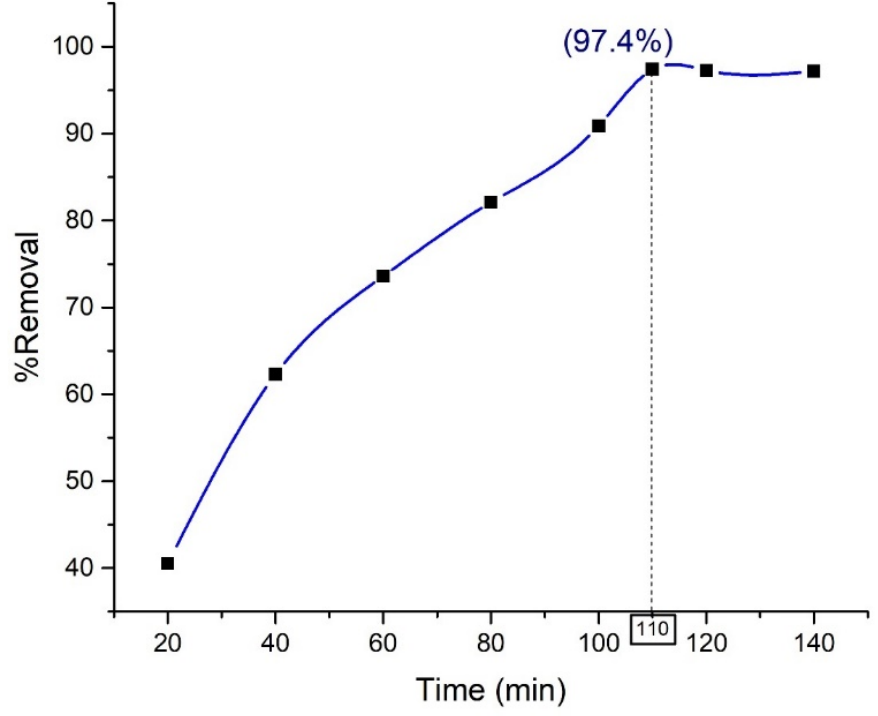
Figure 12. Effect of contact time on the removal of Orange G by nanohybrid Composite 3 (TP 0.75 CS 0.25 ) . (TP 0.75 CS 0.25